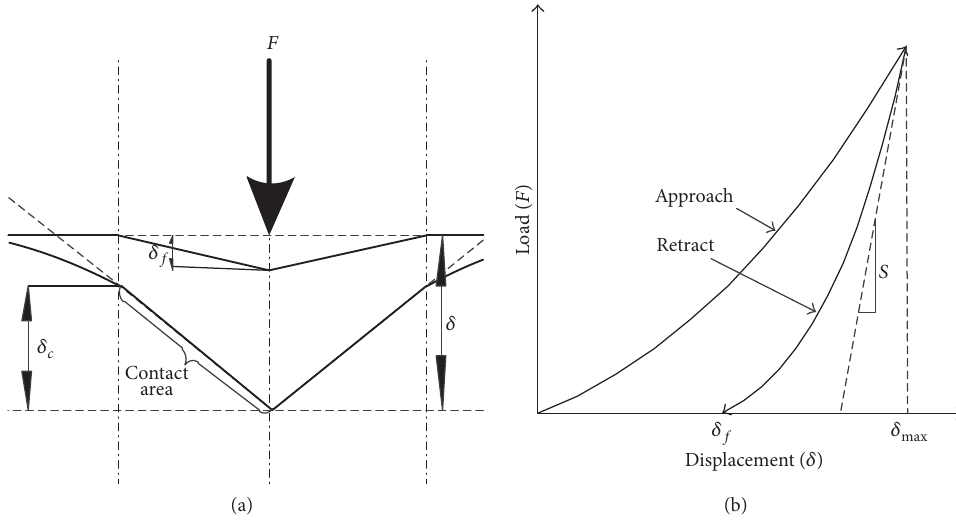
Figure 1: (a) Surface profile during loading with an indenter; (b) schematic of indentation force curve